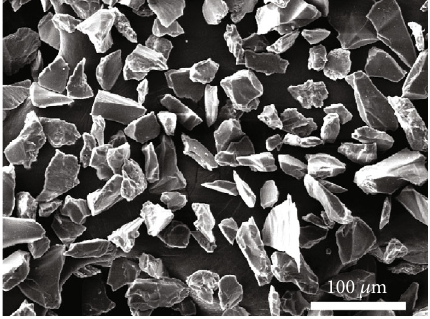
Table 4: Ablation rates of the